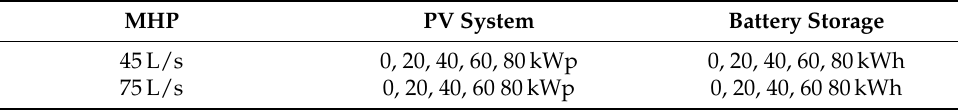
Table 7. Overview of the dimensioning scenarios.